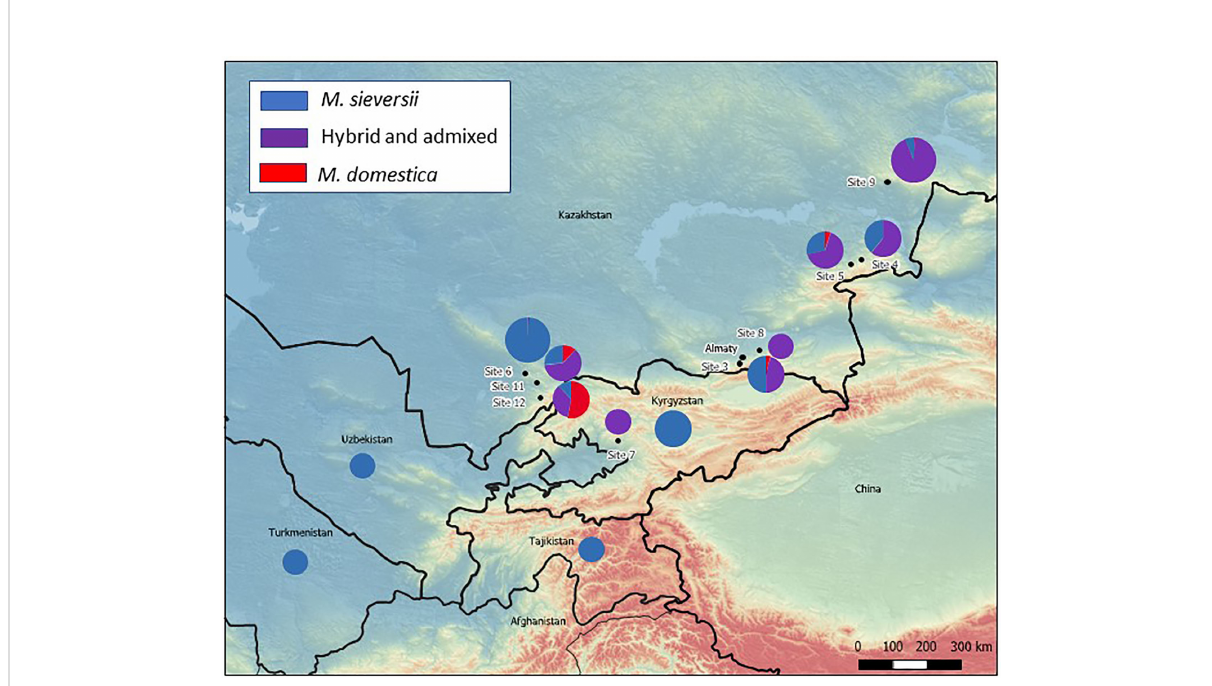
FIGURE 2 Map of M. sieversii collection sites for NPGS apple collection genotyped with a 20K SNP array. The subsequently determined proportions of pure M. sieversii , pure M. domestica , and hybrid/admixed individuals investigated from each site are overlaid as pie charts (small pie chart: 1-10 individuals; medium pie chart: 11-50 individuals; large pie chart: 51-135